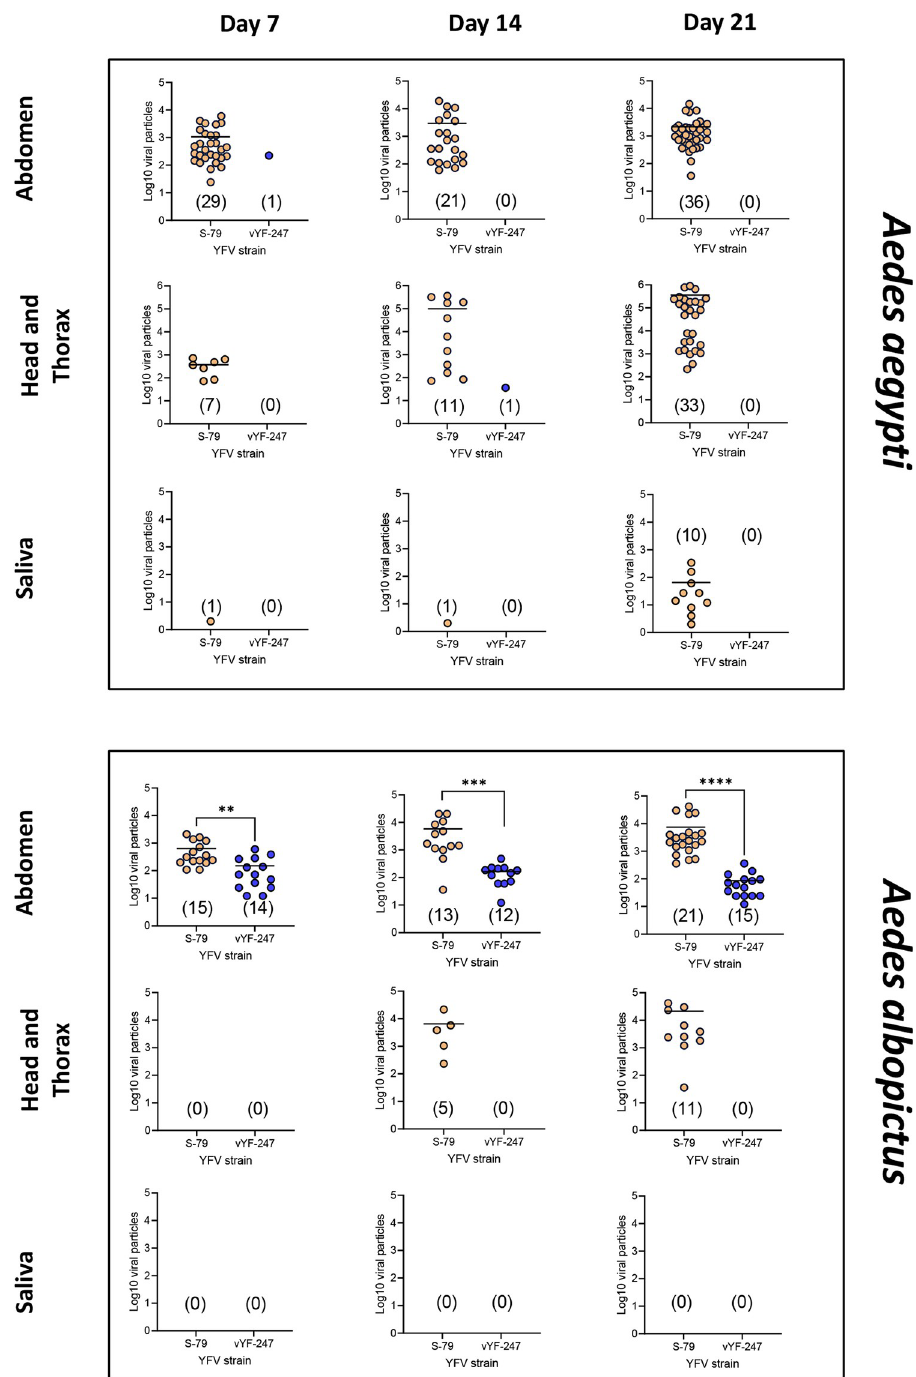
Fig 2. Number of viral particles (Log 10 ) in abdomen, HT, and saliva of Aedes aegypti AAPAEA and Aedes albop ictus ALPROV exposed to vYF-247 and S-79 strains. Mosquitoes were presented to a blood meal provided at a titer of 10 7.5 ffu/mL and examined at 7, 14, and 21 days post-infection. In brackets, number of YFV-positive mosquitoes. Stars indicate statistical significance of comparisons by Kruskal-Wallis test: �� p � 0.01, ��� p � 0.001, ���� p �